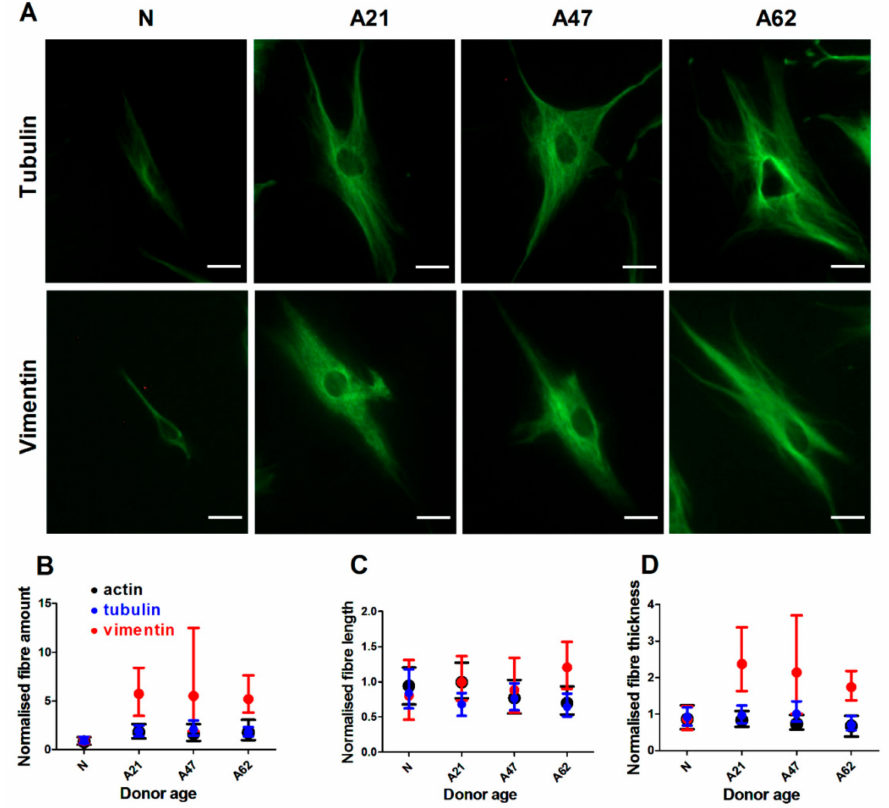
Figure 3. Age has the highest influence on intermediate filaments. ( A ) Represantative epifluorescence images showing tubulin and vimentin organization of cells from donors at di ff erent age. Fibres labelled ageinst tubulin and vimentin (green). Scale bars represent 20 µ m. Corresponding plot of three cytoskeletons showing relative changes in ( B ) fibre amount, ( C ) fibre length, and ( D ) fibre thickness. Vimentin is showing the highest changes compared to F-actin and tubulin. Data are plotted from three independent experiments and normalised to neonatal donor to show the magnitute of changes. The data of all cytoskeletons with real values are presented in Supplementary Figure